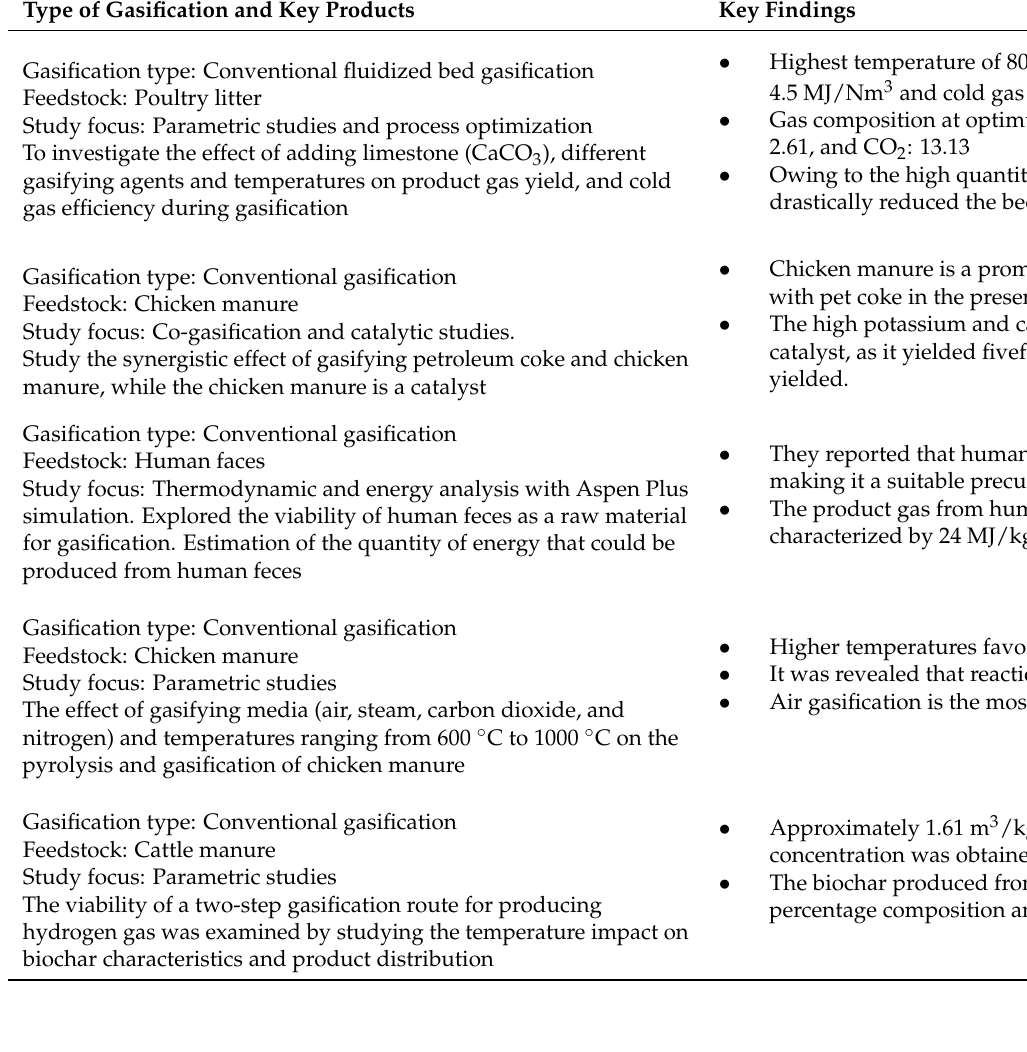
Table 5. Summary of the studies related to heterogeneous catalyzed gasification of human and animal waste, kinetics studies, and process integration